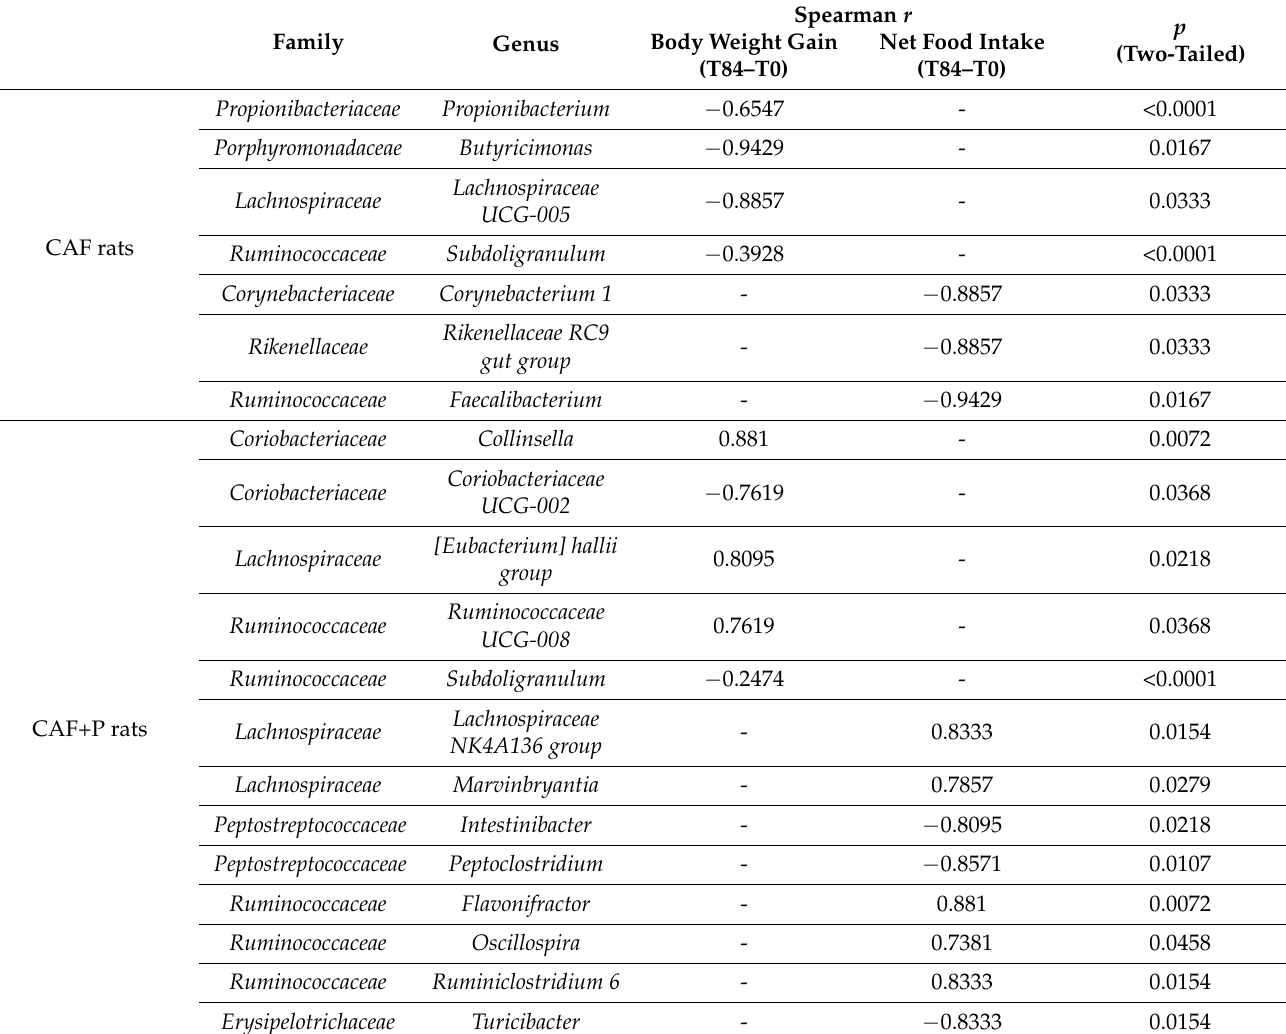
Table 3. Statistically significant correlations between the taxa relative abundances and variation of body weight and food intake in CAF and CAF+P